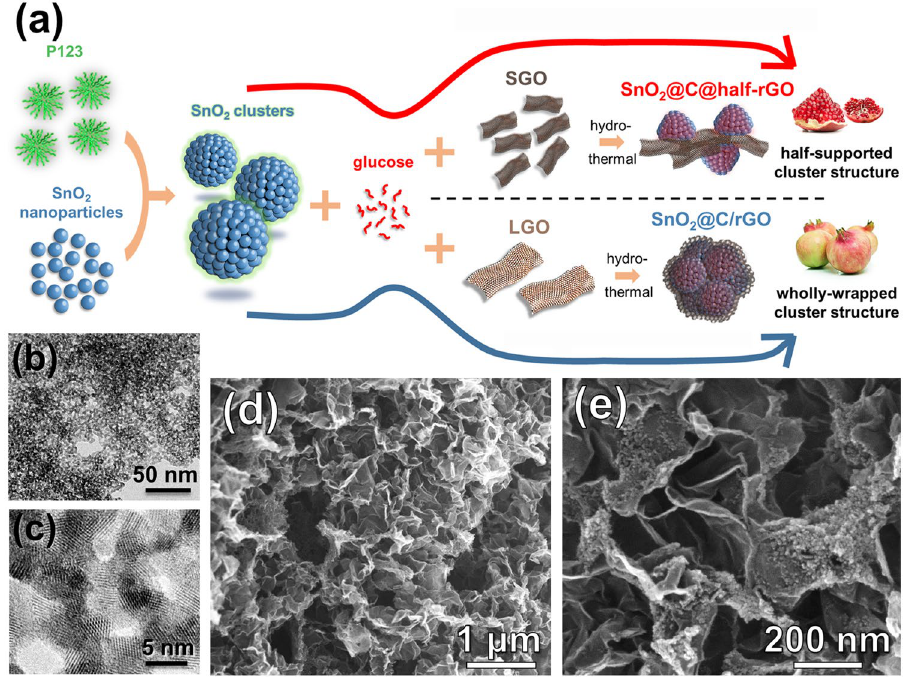
Figure 1. ( a )Graphical synthesis route of SnO 2 @C@half-rGO and SnO 2 @C/rGO. ( b,c ) TEM images of the